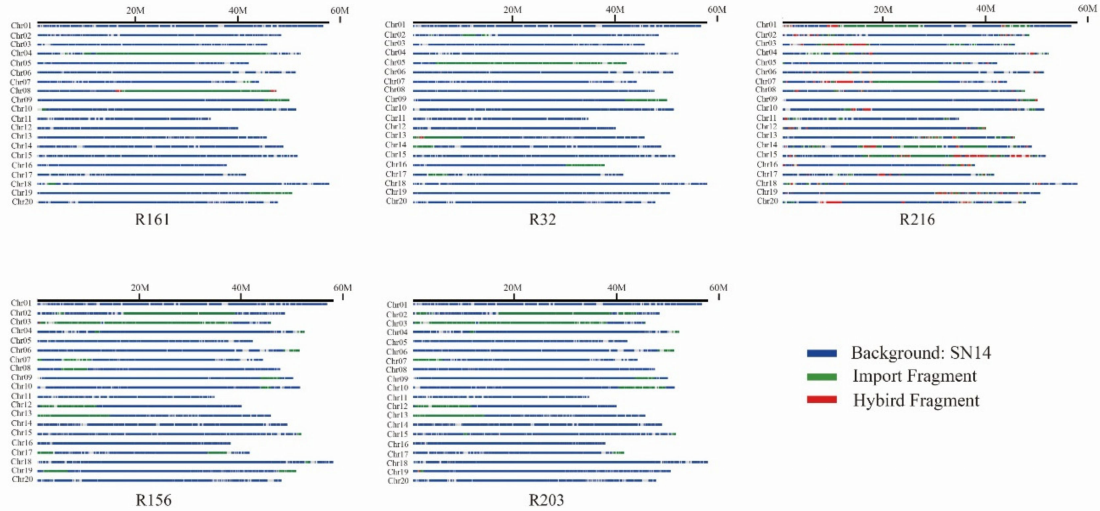
Figure 4. Schematic structures of the substituted segments in extremely dominant materials. Blue, green, and red represent the background SN14, import fragment, and hybrid fragment,